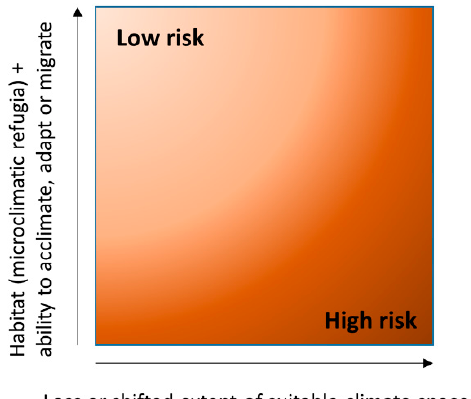
Figure 5. Conceptually, bioclimatic models estimating exposure to larger-scale climate change can be cross-referenced with a species ecological response relating to habitat specialisation and microclimatic niche availability, dispersal rate, genetic diversity or acclimation potential, in order to map an overall climate change risk score and to identify indicator species for conservation.